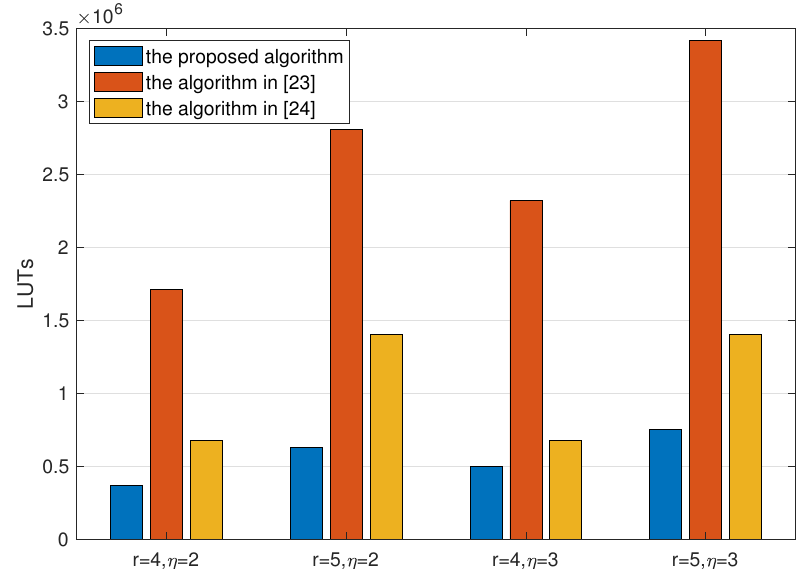
Figure 11. Complexity comparison of different turbo-Hadamard